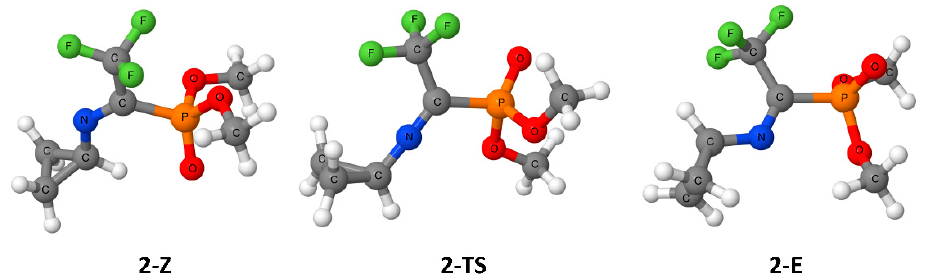
Figure 6. Optimized structures of Z- and E-isomers ( 2-Z and 2-E , respectively) and the transition state of the isomerization reaction 2-Z → 2-E ( 2-TS